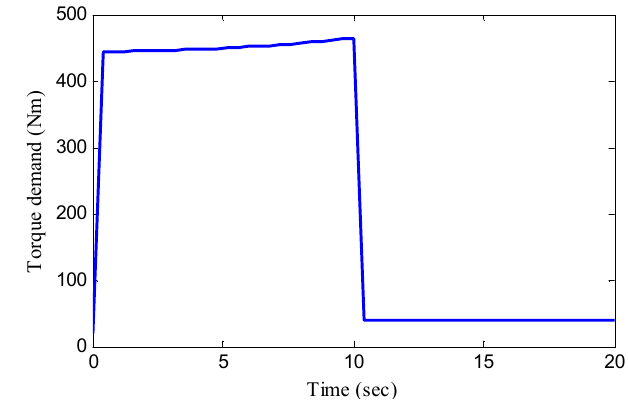
Figure 8. Torque demand in case study 1.